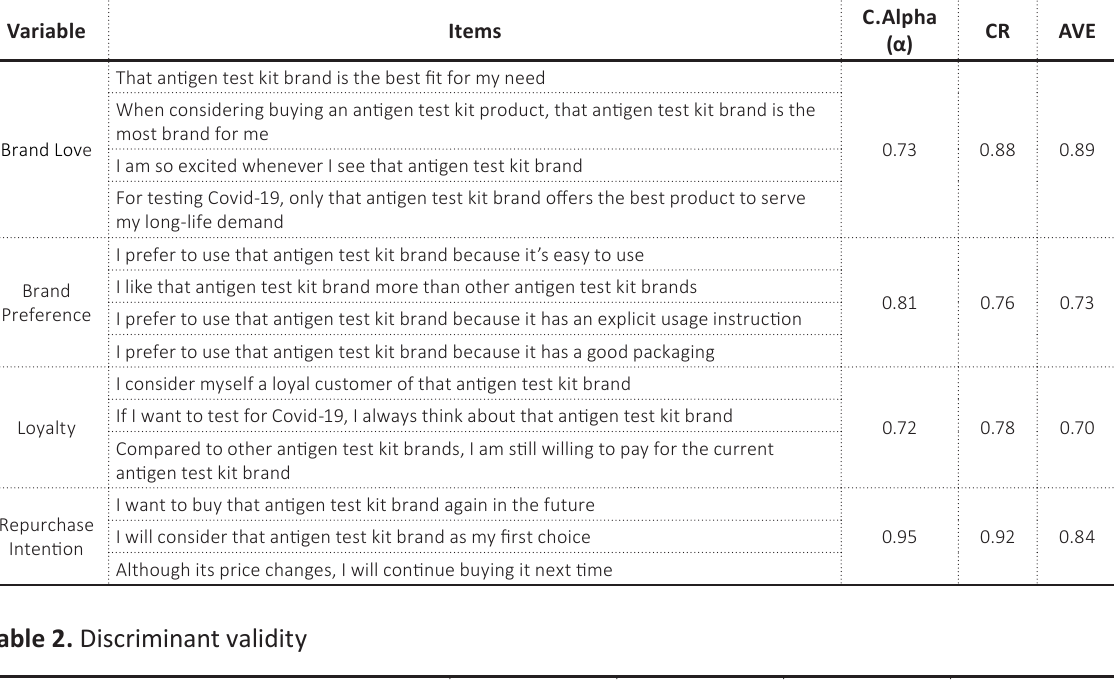
Table 1. Reliability and convergent validity